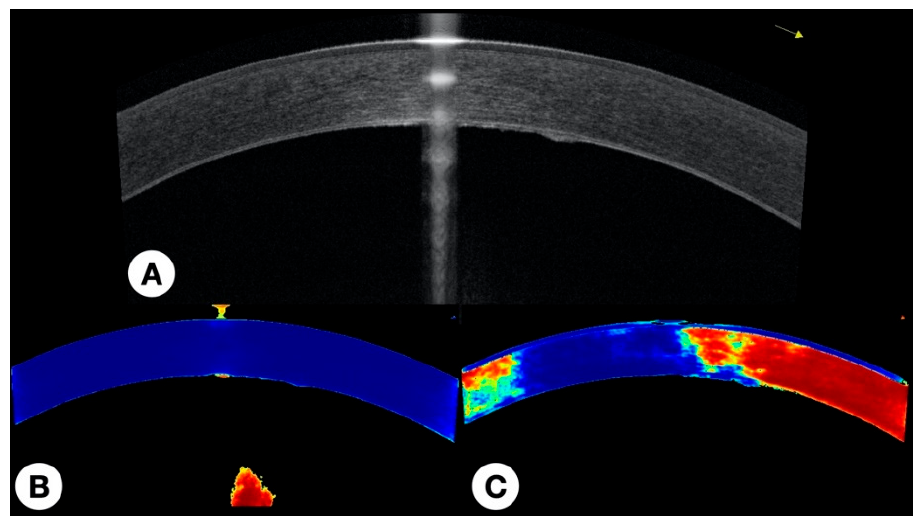
Figure 8. Example of an OCT image ( A ) from a patient with a DCCT of 35 μ m. Corresponding colored heat map of the output probabilities of edema of our previous model ( B ) and of our current pipeline ( C ). Hotter colors indicate higher probabilities of edema. (OCT: Optical Coherence Tomography; DCCT: Differential Central Corneal Thickness) .